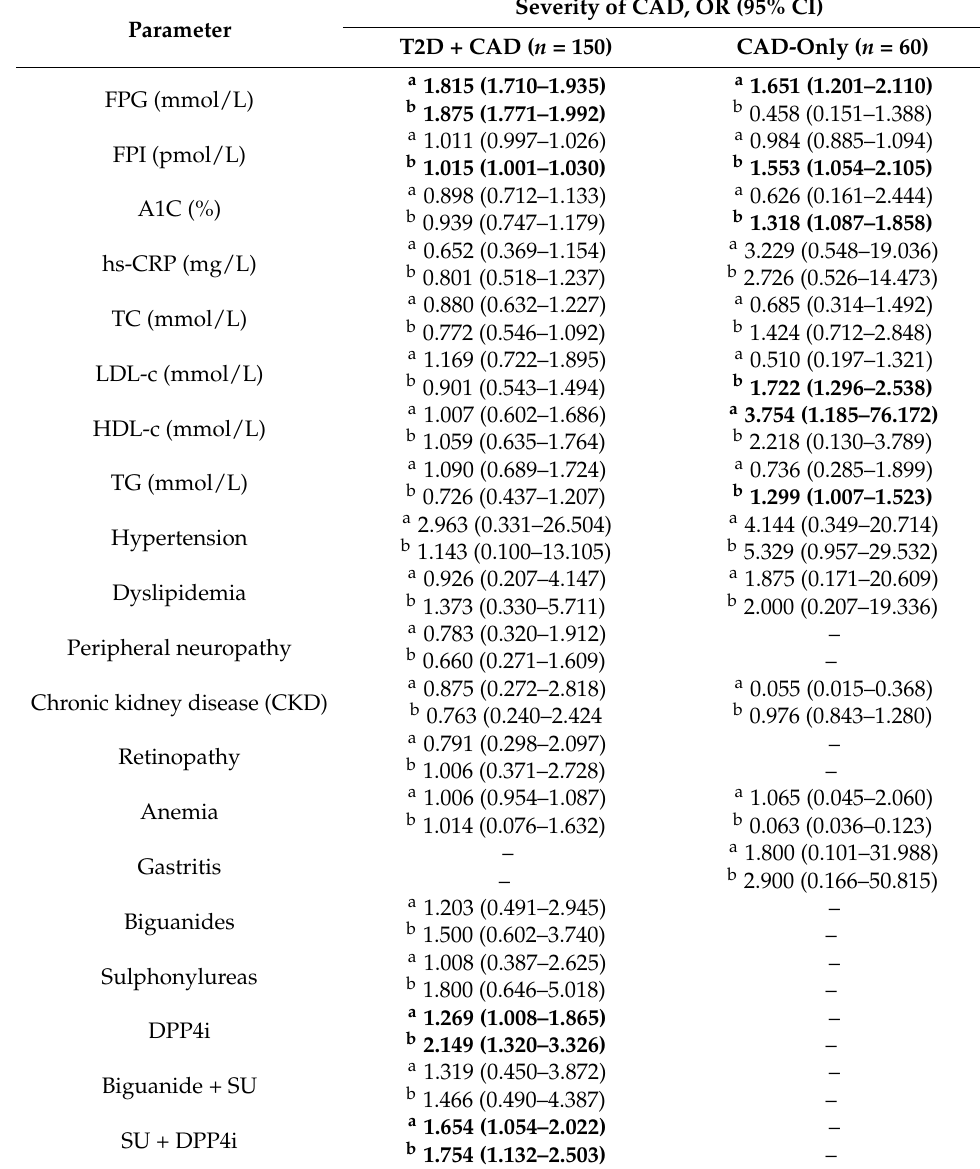
Table 3. Association between clinical factors and the severity of CAD in study